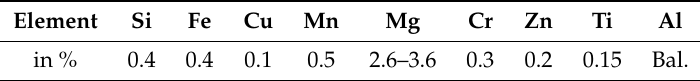
Table 1. Composition of EN AW-5754 H22 [EN 573-3:2013].